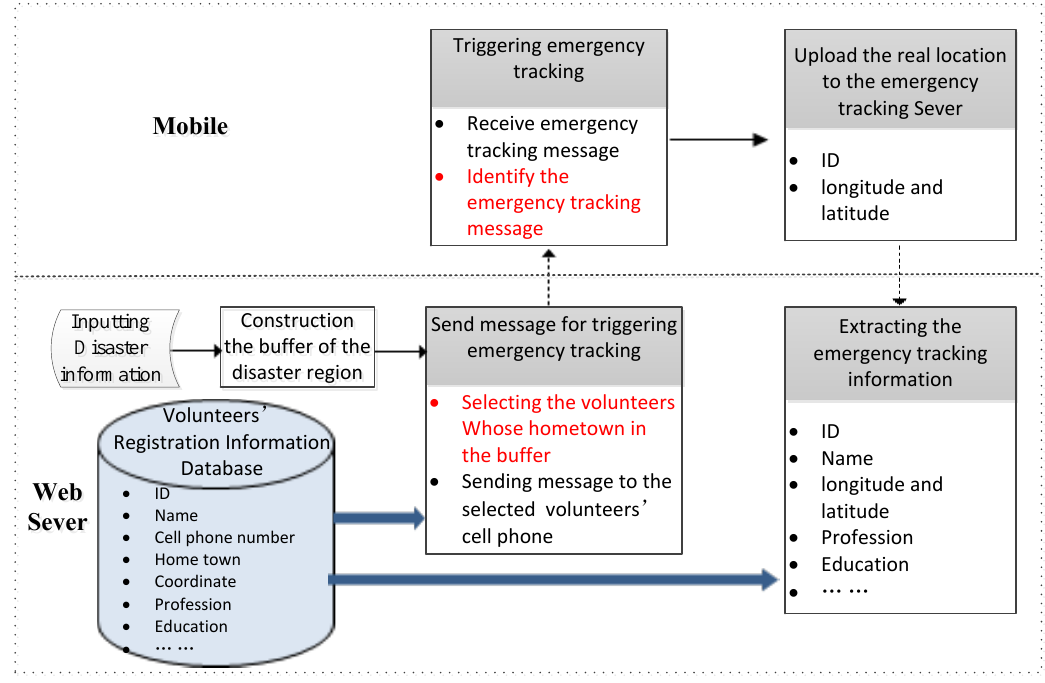
Figure 1. The strategy for the emergency tracking in great